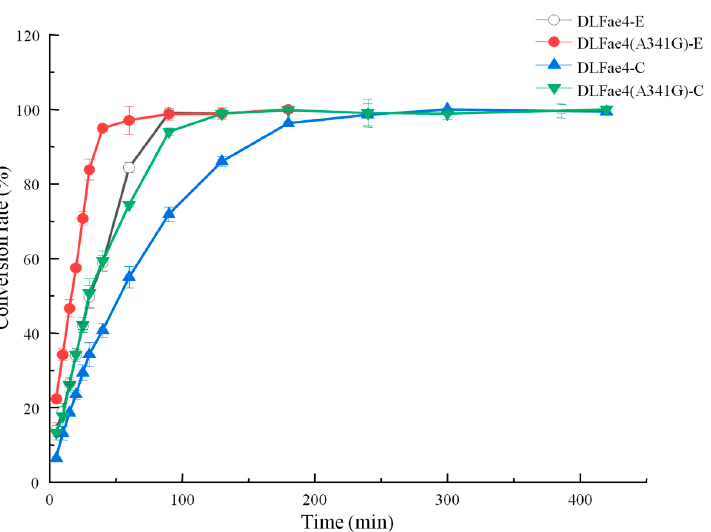
Figure 5. DLFae4 and A341G catalyze the synthesis of benzyl acetate (circle) and benzyl methyl carbonate (triangle) in phosphate buffer. DLFae4-E: the conversion of benzyl acetate by DLFae4, DLFae4 (A341G)-E: the conversion of benzyl acetate by variant DLFae4 (A341G), DLFae4-C: the conversion of benzyl methyl carbonate by DLFae4, DLFae4 (A341G)-C: the conversion of benzyl methyl carbonate by variant DLFae4 (A341G). Note: All assays were performed in triplicate, and the values shown are mean ± standard deviation.